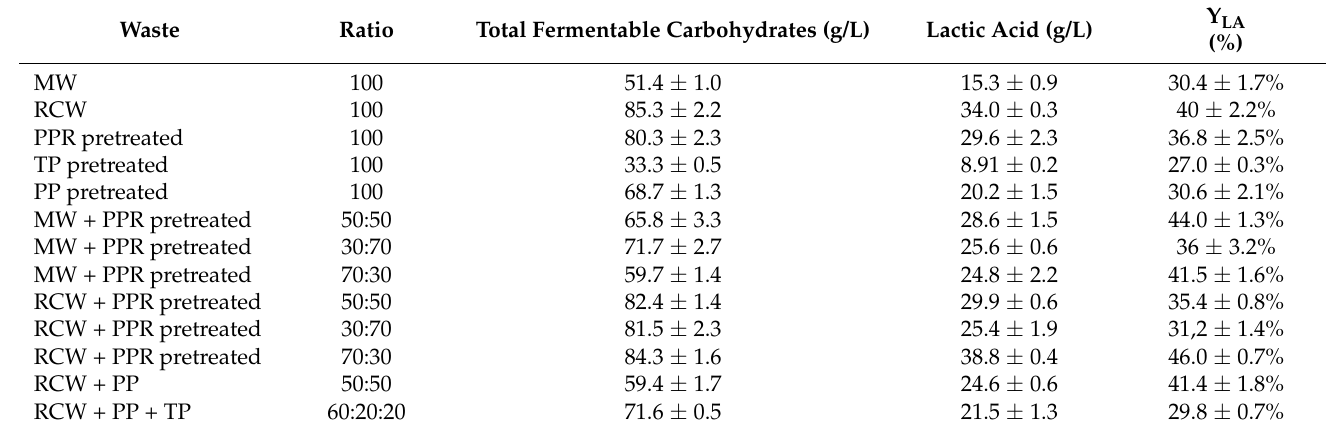
Table 4. Small-scale lactic acid fermentations (100